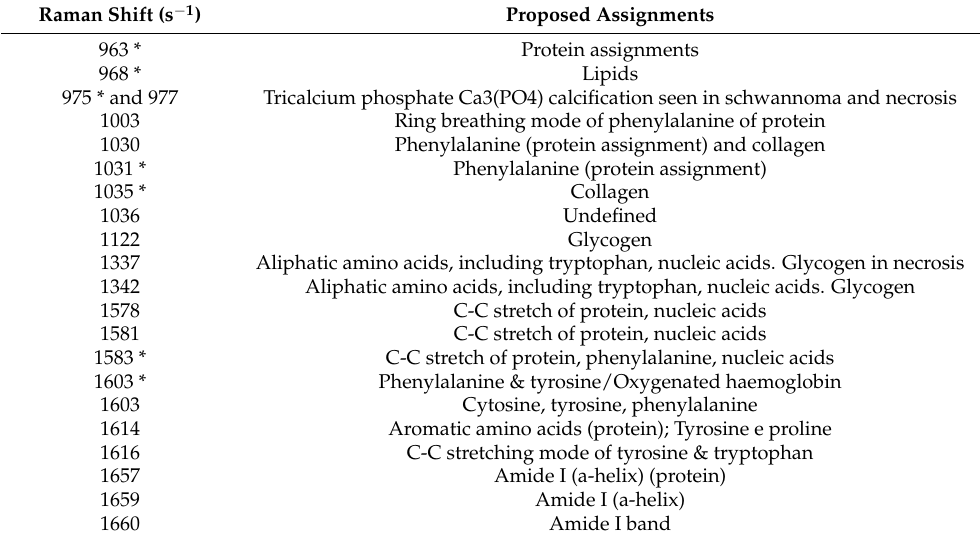
Table 3. Results of classification models for normal vs. glioma tissue biopsies using Raman Spec- troscopy.